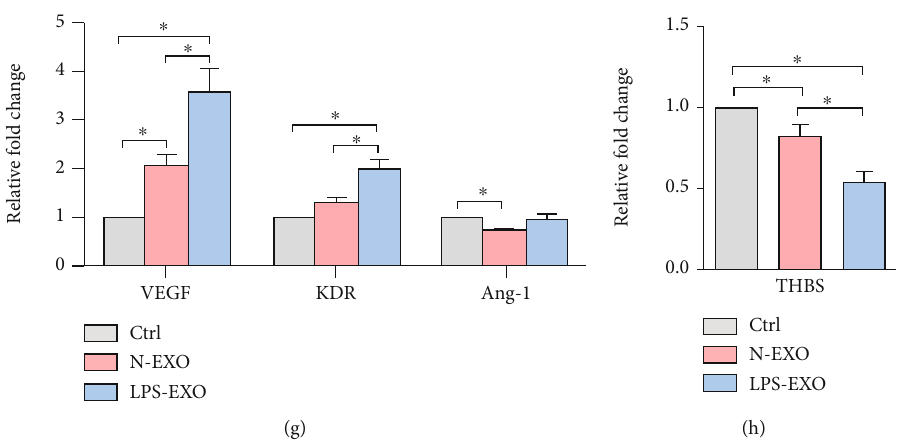
Figure 5: LPS-EXO promotes the angiogenesis of HUVECs. (a) Representative images of the tube formation assay at 1 hour (scale bar, 200 μ m). (b) Representative images of the tube formation assay at 9 hours (scale bar, 200 μ m). (c, d) Quanti fi cation analysis of the number of junction points (c) and total length (d) at 1 hour ( n = 3 ). (e, f) Quanti fi cation analysis of the number of junction points (e) and total length (f) at 9 hours ( n = 3 ). (g) The mRNA expression of proangiogenic genes (VEGF, KDR, and Ang-1) ( n = 3 ). (h) The mRNA expression of antiangiogenic genes (THBS). Data represent means ± SD . ∗ P < 0 : 05